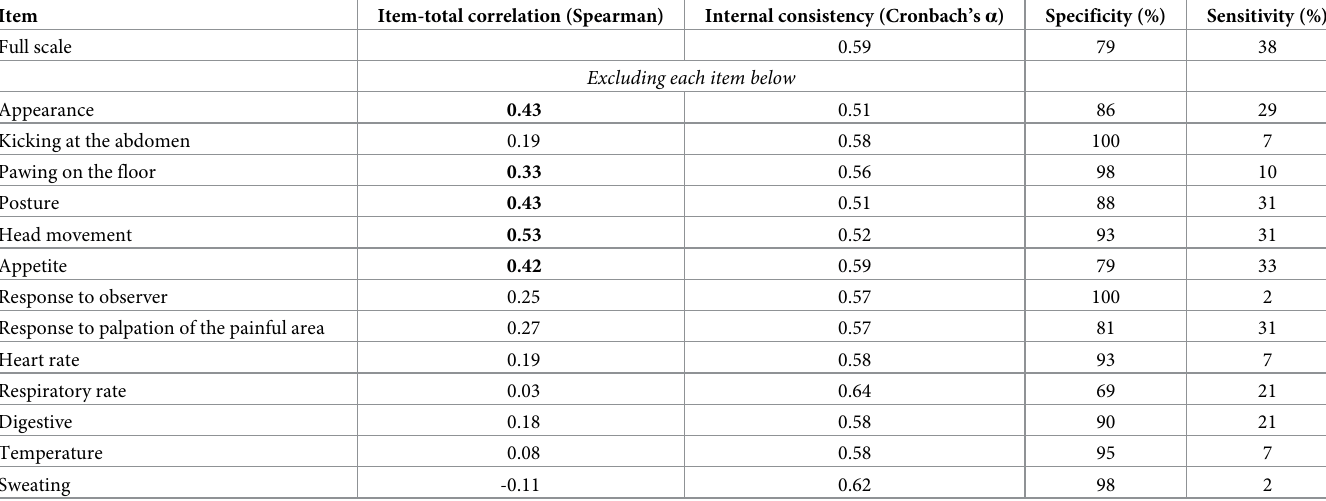
Table 8. Item-total correlation and internal consistency, specificity, and sensitivity for composite pain